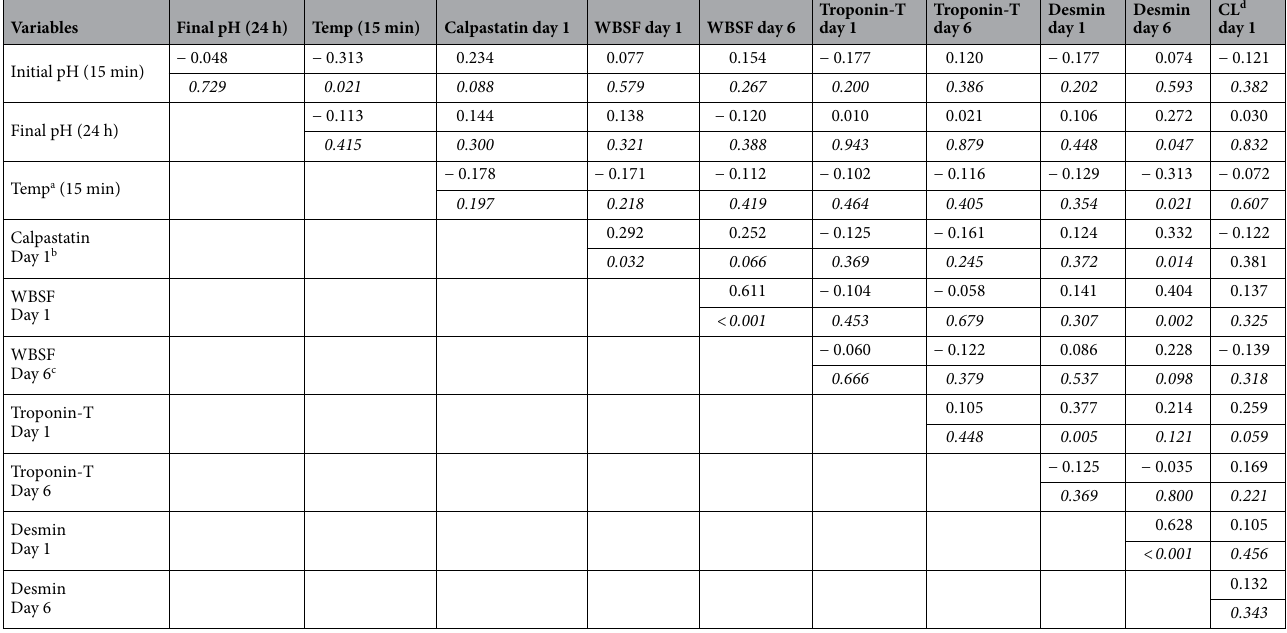
Table 1. Pearson correlation coefficients among the tenderness-related quality variables of loin/rib chops ( Longissimus dorsi ) from carcasses of goats subjected to transportation stress. a Muscle temperature; b 24